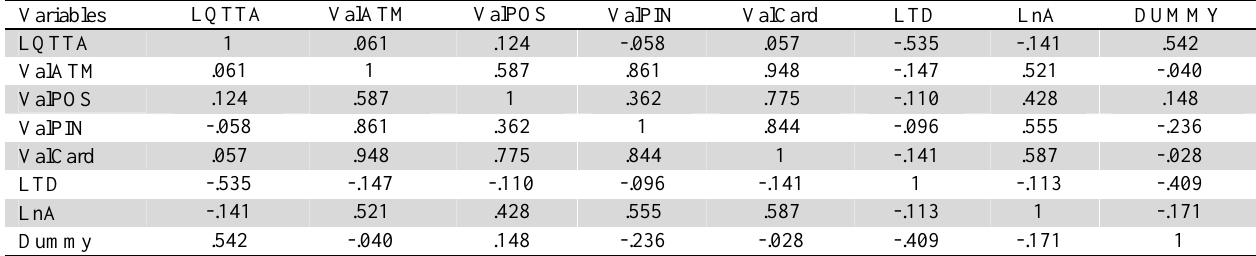
Relationship between independent and dependent variables of the first model